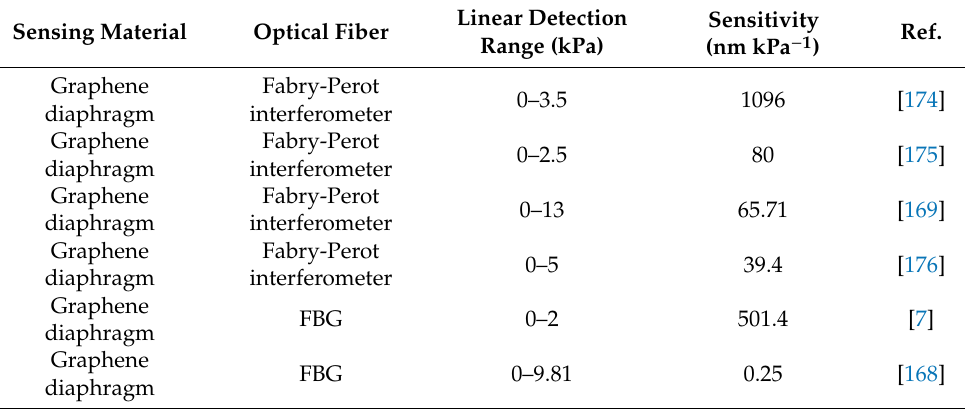
Table 5. Summary of carbon allotrope-based OFS for pressure sensing.